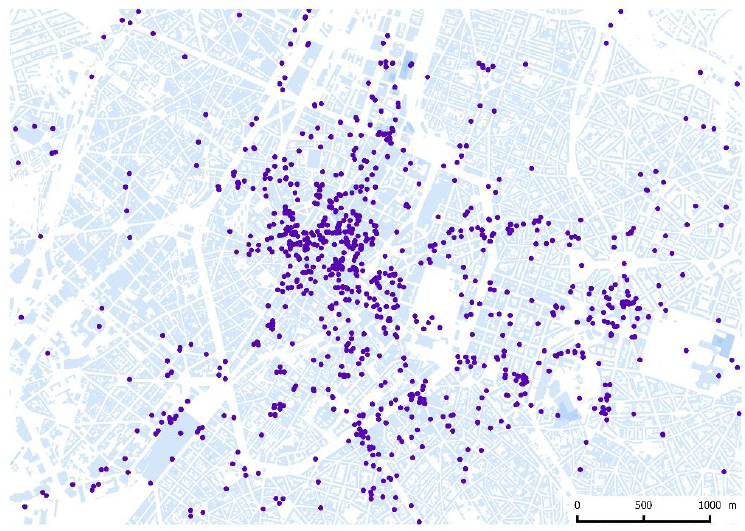
Figure 6. A representation of all the check-ins effected in the center of the city of Brussels, Belgium, during the period of September 2009 to October 2010. The figure shows around 4700 check-ins effected by 742 different users.